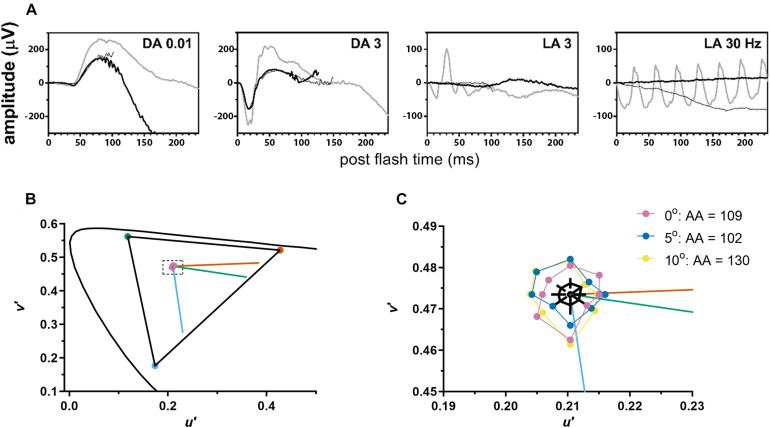
The patient demonstrated normal to near normal retinal function. (A) ffERG testing highlighted unrecordable photopic responses (LA, light adapted) with normal scotopic rod-mediated responses to the dim (DA0.01) flash (DA, dark adapted). Gray waveforms: age-matched healthy control; black waveforms: each eye of the patient. (B) Color discrimination thresholds (purple circles) were close to the white point (center of dashed rectangle) and indistinguishable from healthy volunteers on this graph. Curved line shows CIE 1976 L*u*v* space. Triangle shows the maximum gamut that could be produced by the monitor. Vermillion, green, and blue lines indicate protan, deutan, and tritan confusion lines, respectively. (C) A magnified view of the area inside the dashed rectangle from (B). Mean color discrimination thresholds are plotted for foveal fixation (purple) and for two retinal eccentricities [5° (blue) and 10° (yellow) along the vertical meridian from the superior retina]. For each eccentricity, achromatic area (AA) for the subject with OT was slightly above the upper limit of normal. Black polygon shows mean achromatic area for healthy volunteers and black lines indicate 95% confidence intervals at each of the 8 axes.